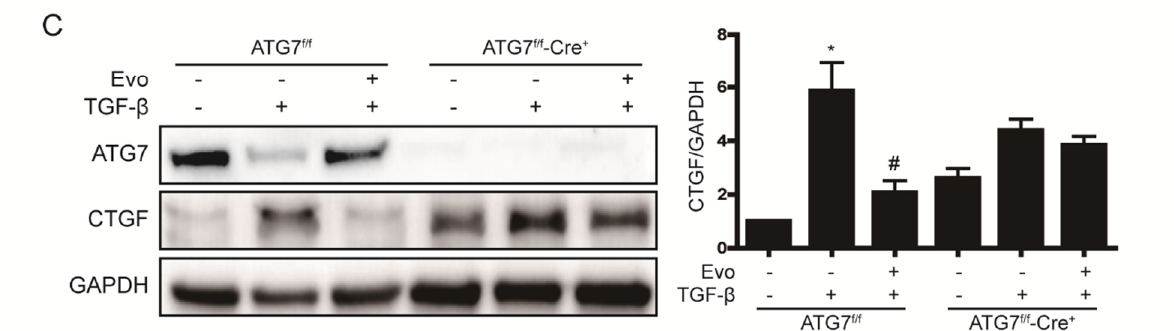
Figure 5. Induction of autophagy is required for evogliptin to prevent inflammatory and fibrotic signaling in liver cells. ( A ) Real-time RT-PCR analysis of the effect of evogliptin on LPS-induced inflammatory signaling in primary hepatocytes from ATG7 f/f -Cre + mice. ** p < 0.01 relative to the control, # p < 0.05, ## p < 0.01 relative to LPS. ( B ) iNOS production and cytokine secretion in primary hepatocytes from ATG7 f/f -Cre + mice. ** p < 0.01 relative to the control, # p < 0.05, ## p < 0.01 relative to LPS. ( C ) Western blot analysis of the effect of evogliptin on TGF- β -induced CTGF expression in primary hepatocytes from ATG7 f/f -Cre + mice. Data in the bar graph are represented as the mean ± SEM. * p < 0.05 relative to the control, # p < 0.05 relative to TGF- β .